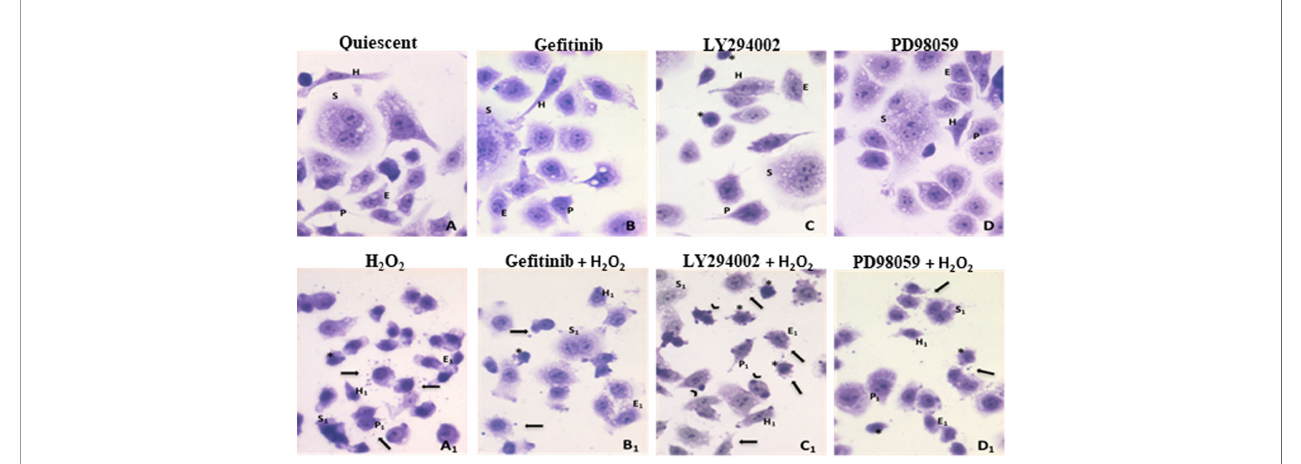
FIGURE 1 | Effects of oxidative stress induced by H 2 O 2 treatments combined to ErbB pathway inhibitors on AGS cells. (A) -Quiescent cells. Different morphological cellular phenotypes: (H) mononucleated and elongated cells, “ hummingbird ” -like; (S) multinuclear large syncytial cells; (E) epithelial-like polygonal little cells; (P) cells exhibiting a very thin prolongation from the cellular body. (B) -Ge fi tinib treatment (1µM), (C) -LY294002 treatment (25µM), cells with heterochromatic nucleus were evidenced (asterisks), (D) -PD98059 treatment (50µM). (A1 – D1) Inhibitors and H 2 O 2 (10mM) co-exposure: after H 2 O 2 exposure, in all cases, a general shrinkage of all different cell phenotypes was observed (H 1 , S 1 , E 1 , P 1 represent the original features still recognizable), in addition to the presence of extracellular vesicles (arrows) and many small, round cells with heterochromatic nuclei (asterisks). (C1) Larger and darker vesicles emerging from cell surface are detected after LY294002 and H 2 O 2 exposure (arrows). Toluidine blue staining